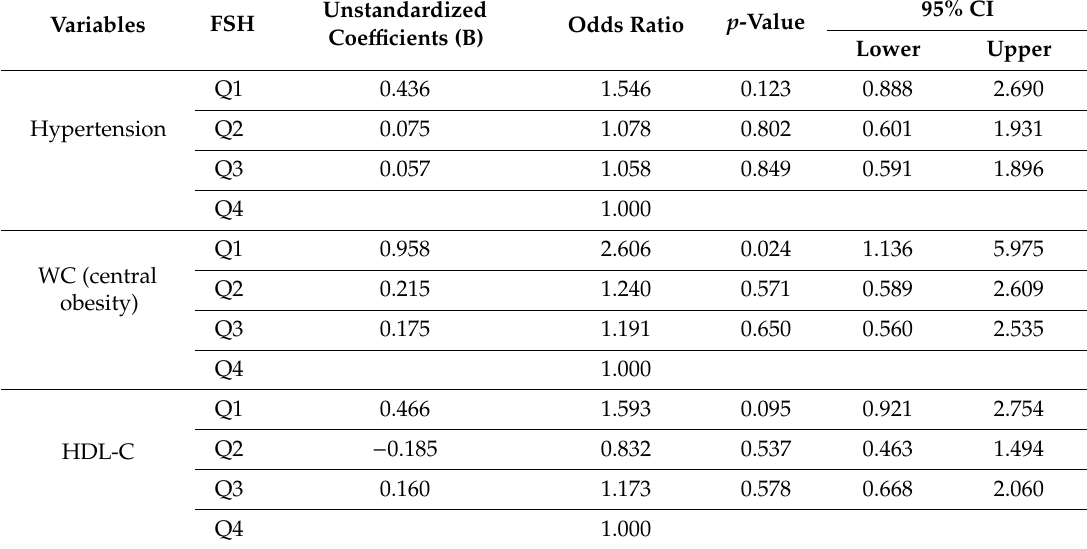
Table 5. Associations between follicle-stimulating hormone and components of metabolic syndrome in post-menopausal